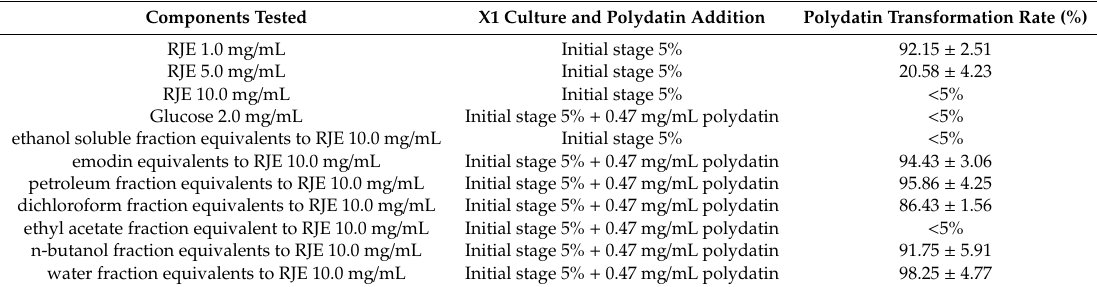
Table 6. E ff ects addition of di ff erent components on the biotransformation of polydatin to